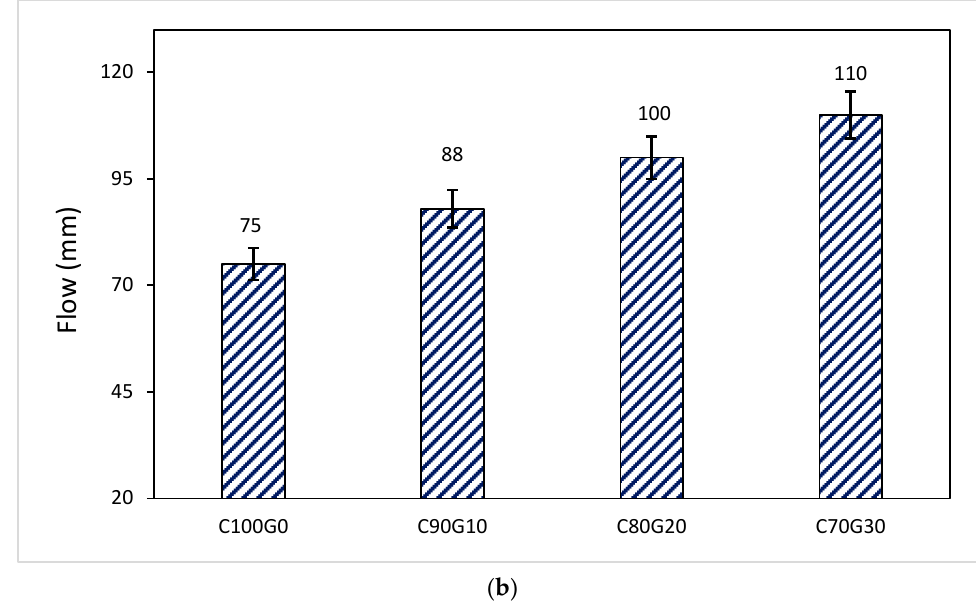
Figure 5. ( a ) Variation of flow with glass powder content in mortar. ( b ) Variation of flow with glass powder content in concrete.